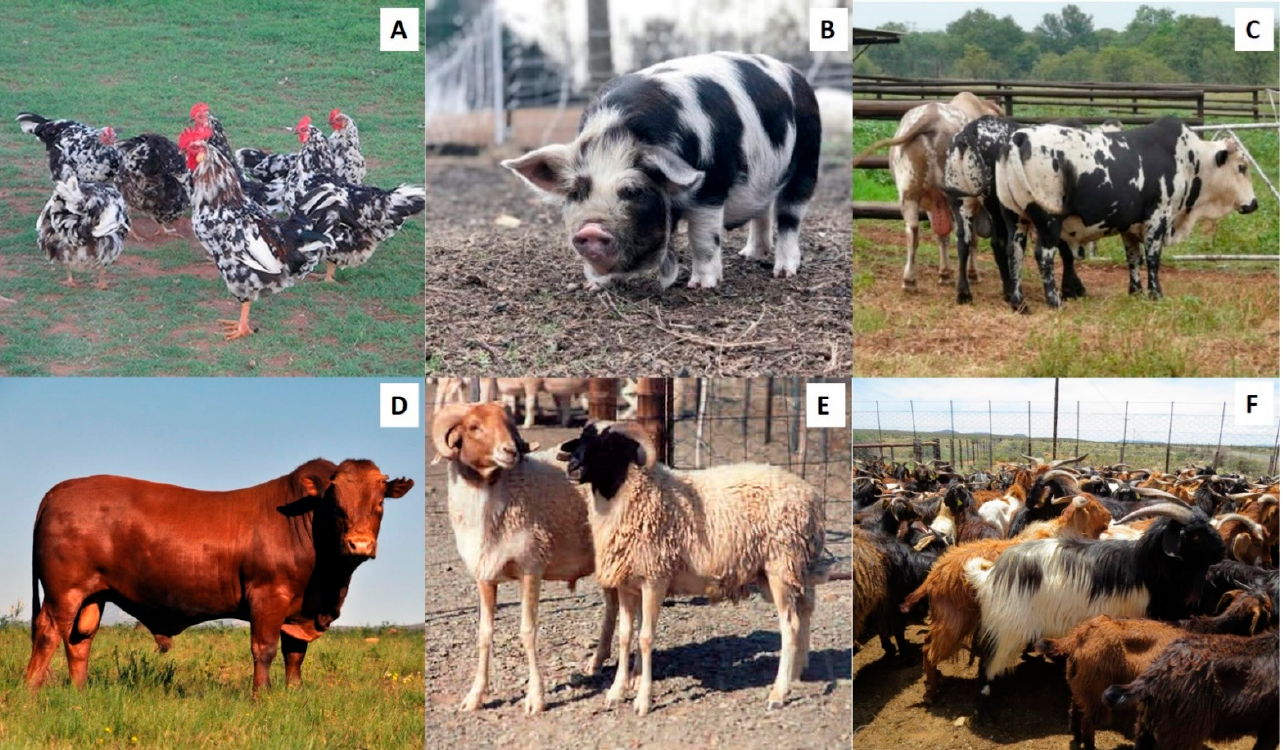
Figure 4. Examples of indigenous domestic breeds in South Africa. ( A ) Venda chickens, ( B ) Kolbroek pig, ( C ) Nguni cattle, ( D ) Bonsmara bull, ( E ) Namaqua-Afrikamer sheep, and ( F ) Tankwa goats.